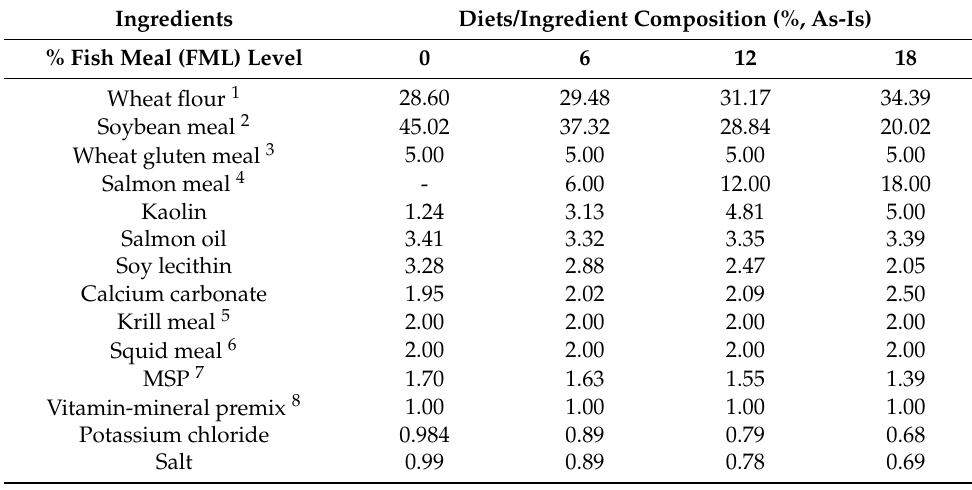
Table 3. Ingredient composition (%, as-is) of diets used to evaluate digestibility.